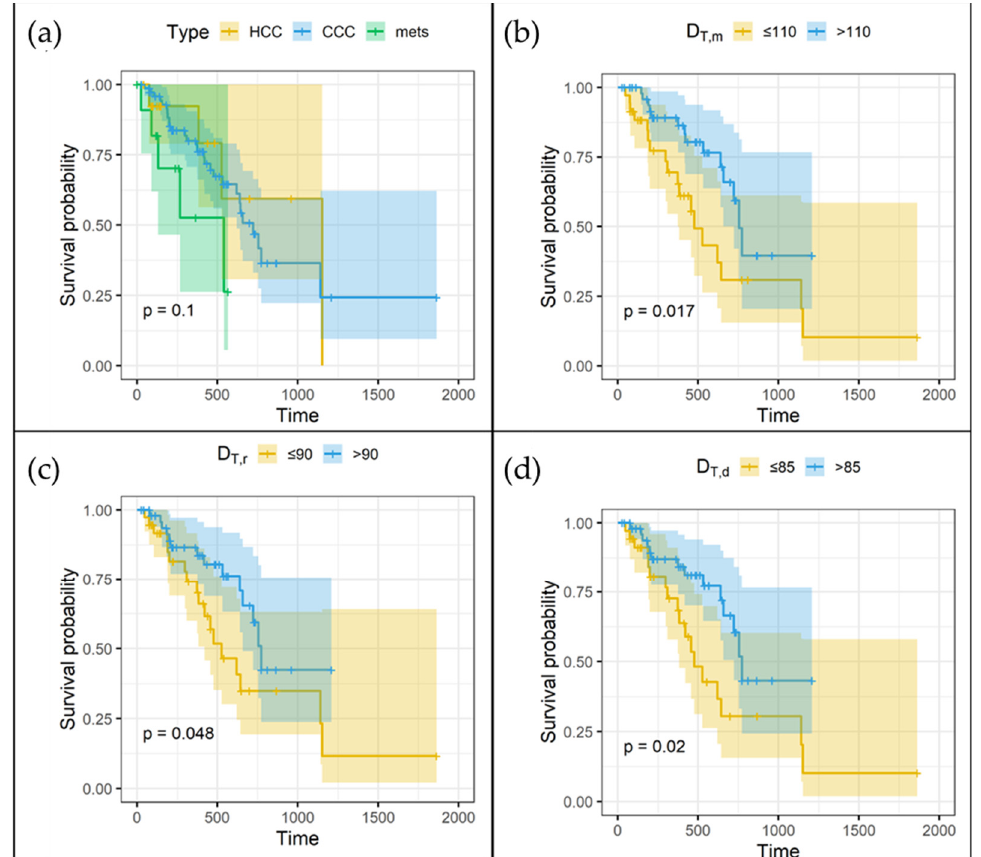
Figure 4. Kaplan–Meier curves of OS according to the ( a ) tumor type; K–M curves of OS for all HCC, CCC and mixed HCC/CCC patients according to the pre-TARE tumor mean absorbed dose for ( b ) manual, and post-TARE tumor mean absorbed dose with ( c ) rigid and ( d ) deformable registration approaches. Time is expressed in days.